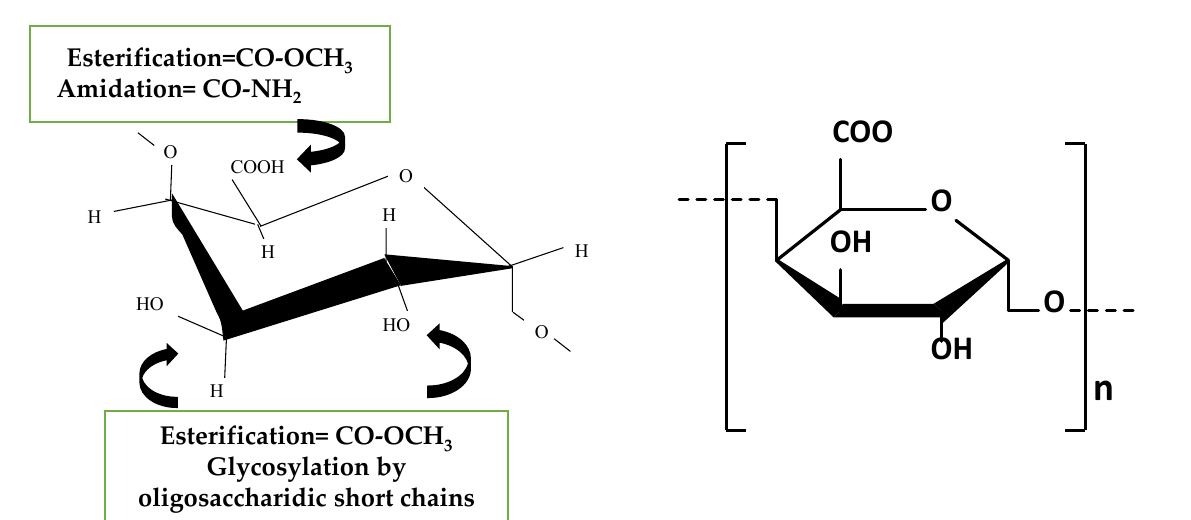
Figure 1. Pectin structure [15,16].